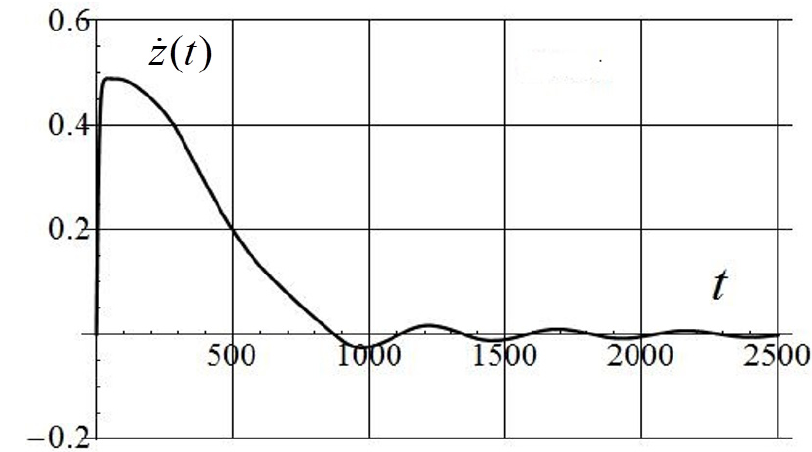
Figure 22. Speed of submersion versus time for a steel cylinder in hanging mode: l ∗ = l c = 2, η = 0.005.